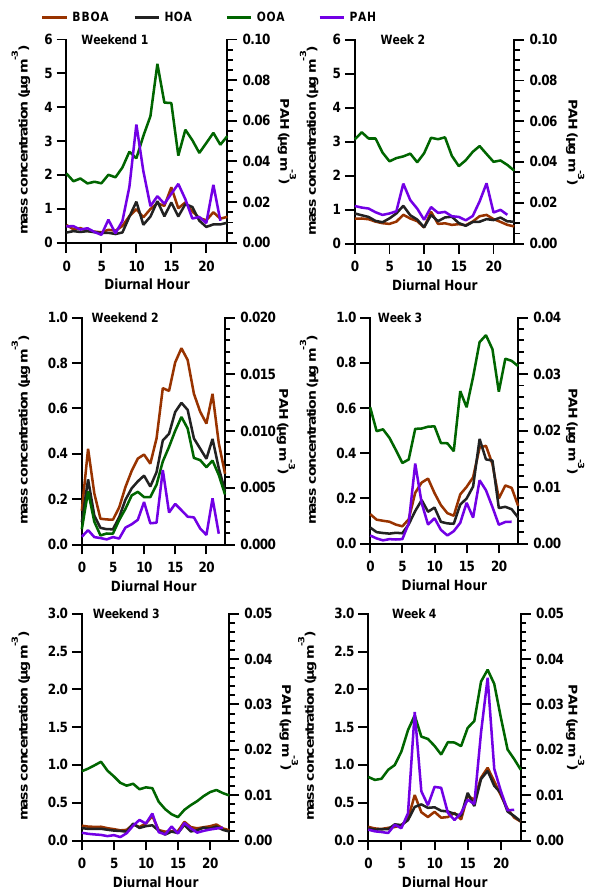
Fig. 6. Diurnal variations of the organic factors (BBOA, HOA and OOA) and PAH concentrations during weekends (left) and weeks (right). Week and weekend number referred to time periods de- scribed in Fig.